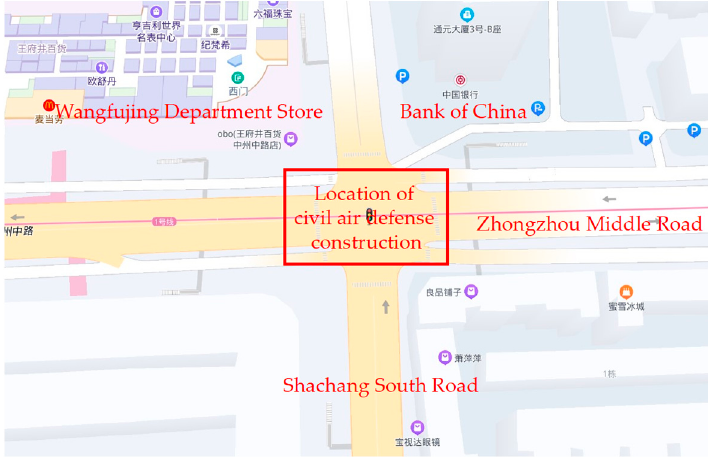
Figure 2. Schematic diagram of project location.